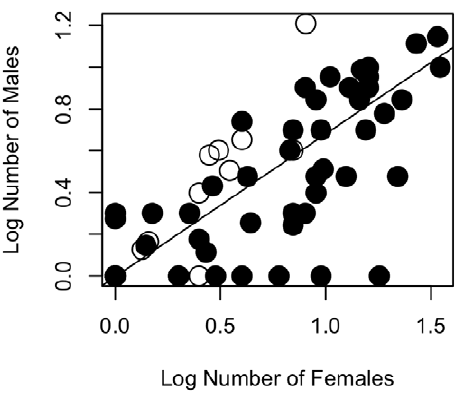
Figure 1. Association between number of males and number of females in primate groups. Data are log 10 transformed. The regression slope of 0.68 was obtained as the mean of the posterior probability distribution from the MCMC analysis (Table 1, Fig. 2) and was forced on to the raw data. The intercept of 2 0.0035 was also obtained from the phylogenetic analysis. Haplorhines are represented with black circles and strepsirrhines with open circles.